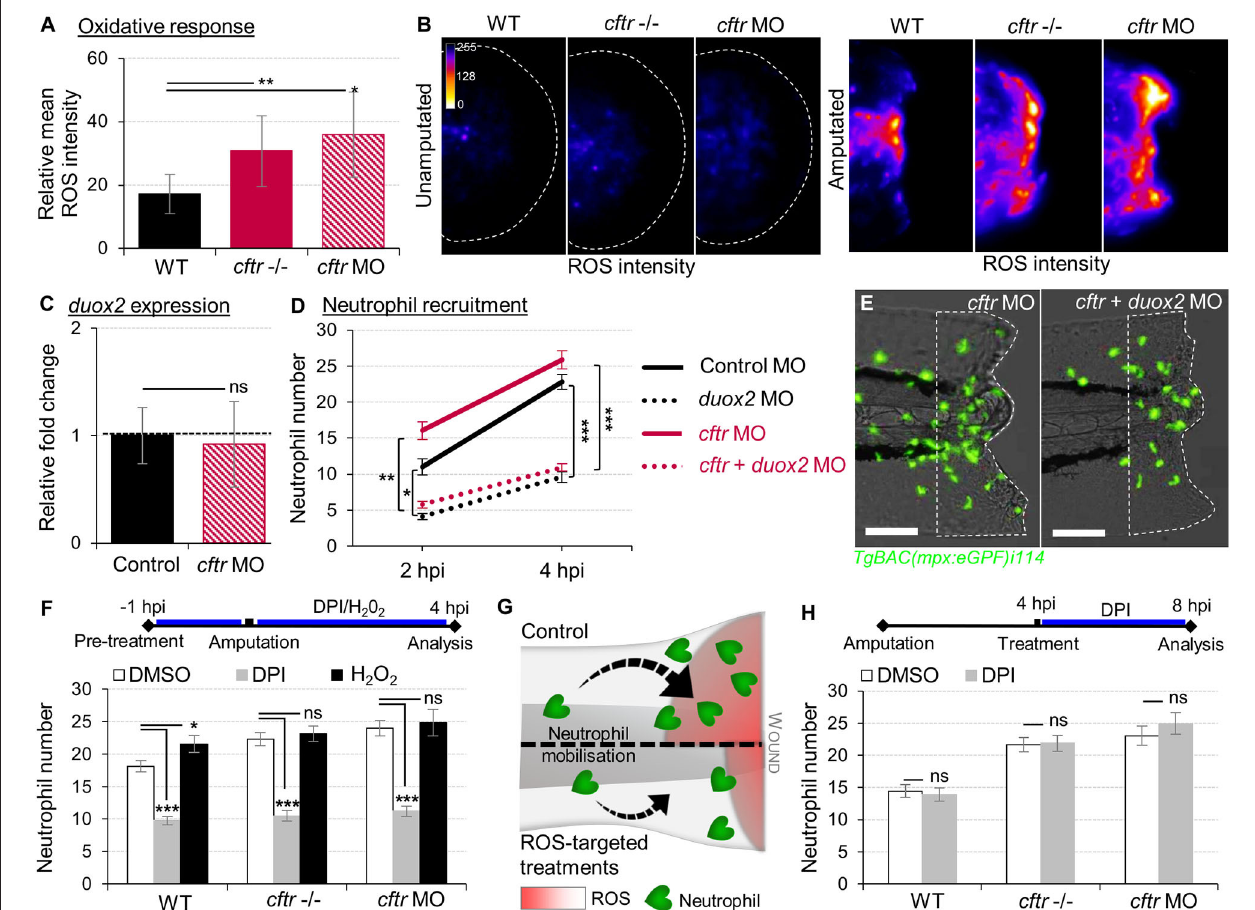
FIGURE 2 | Exuberant wound-induced oxidative responses drive the overactive neutrophilic response in CF larvae. (A,B) WT, cftr –/– and cftr MO stained with CellROX ® to label H 2 O 2 production. Means ± SEM ROS intensity at 30min post-injury (mpi) (A) and associated pseudocolored photomicrographs of uninjured and injured tails revealing ROS production (B) ( n = 15; one-way ANOVA with Dunnett’s post-test). (C) mRNA levels of duox2 gene in tail fin tissue at 30 mpi. Gene expression was expressed as fold change over tail fin tissue from uninjured larvae (30 fins per replicate; mean relative ± SEM gene expression; two-tailed Student t -test). (D) TgBAC(mpx:EGFP)i114 controls, cftr, duox2, and double cftr/duox2 morphants were tail amputated and neutrophils at wounds were enumerated at 2 and 4 hpi. ( n = 21; two-way ANOVA with Tukey post-test). (E) Representative photomicrographs of injured tails at 4 hpi (scale bars, 200 µ m). (F) WT, cftr –/– and cftr